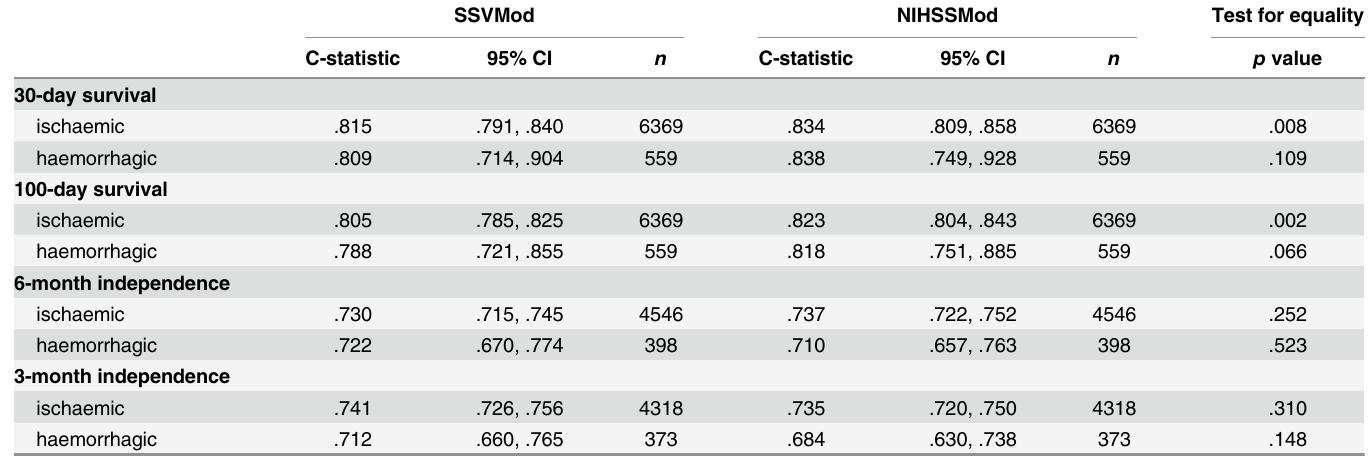
Table 6. C-statistics for survival and independence in subgroups defined by type of stroke (ischaemic and haemorrhagic). The p values from the tests for equality of the C-statistics should be interpreted with regard to the differing denominators of ischaemic and haemorrhagic